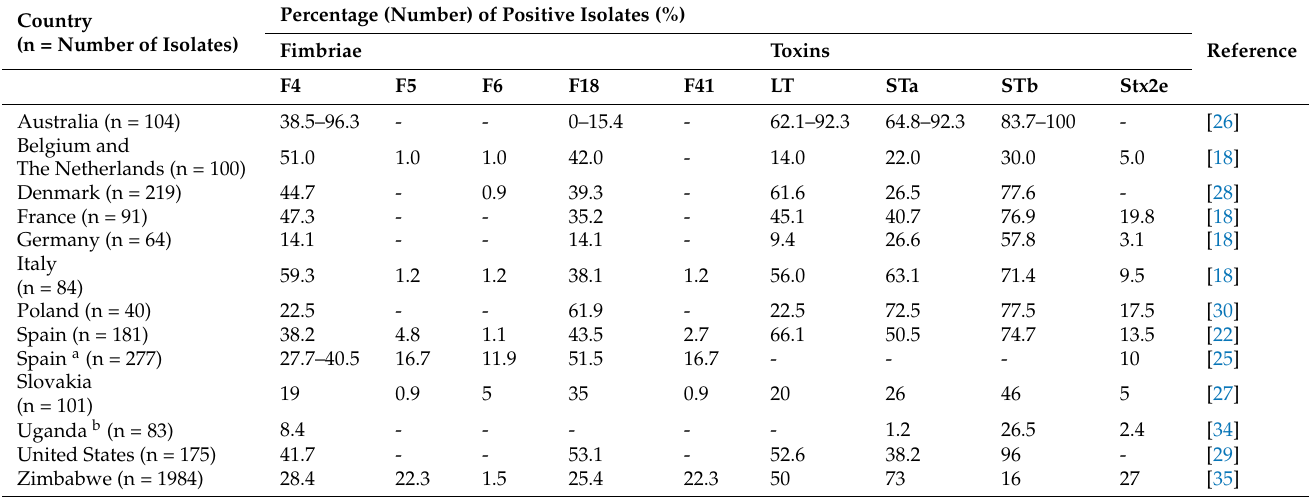
Table 3. The prevalence of the most known fimbriae and toxins in ETEC strain isolates from swine. Country (n = Number of